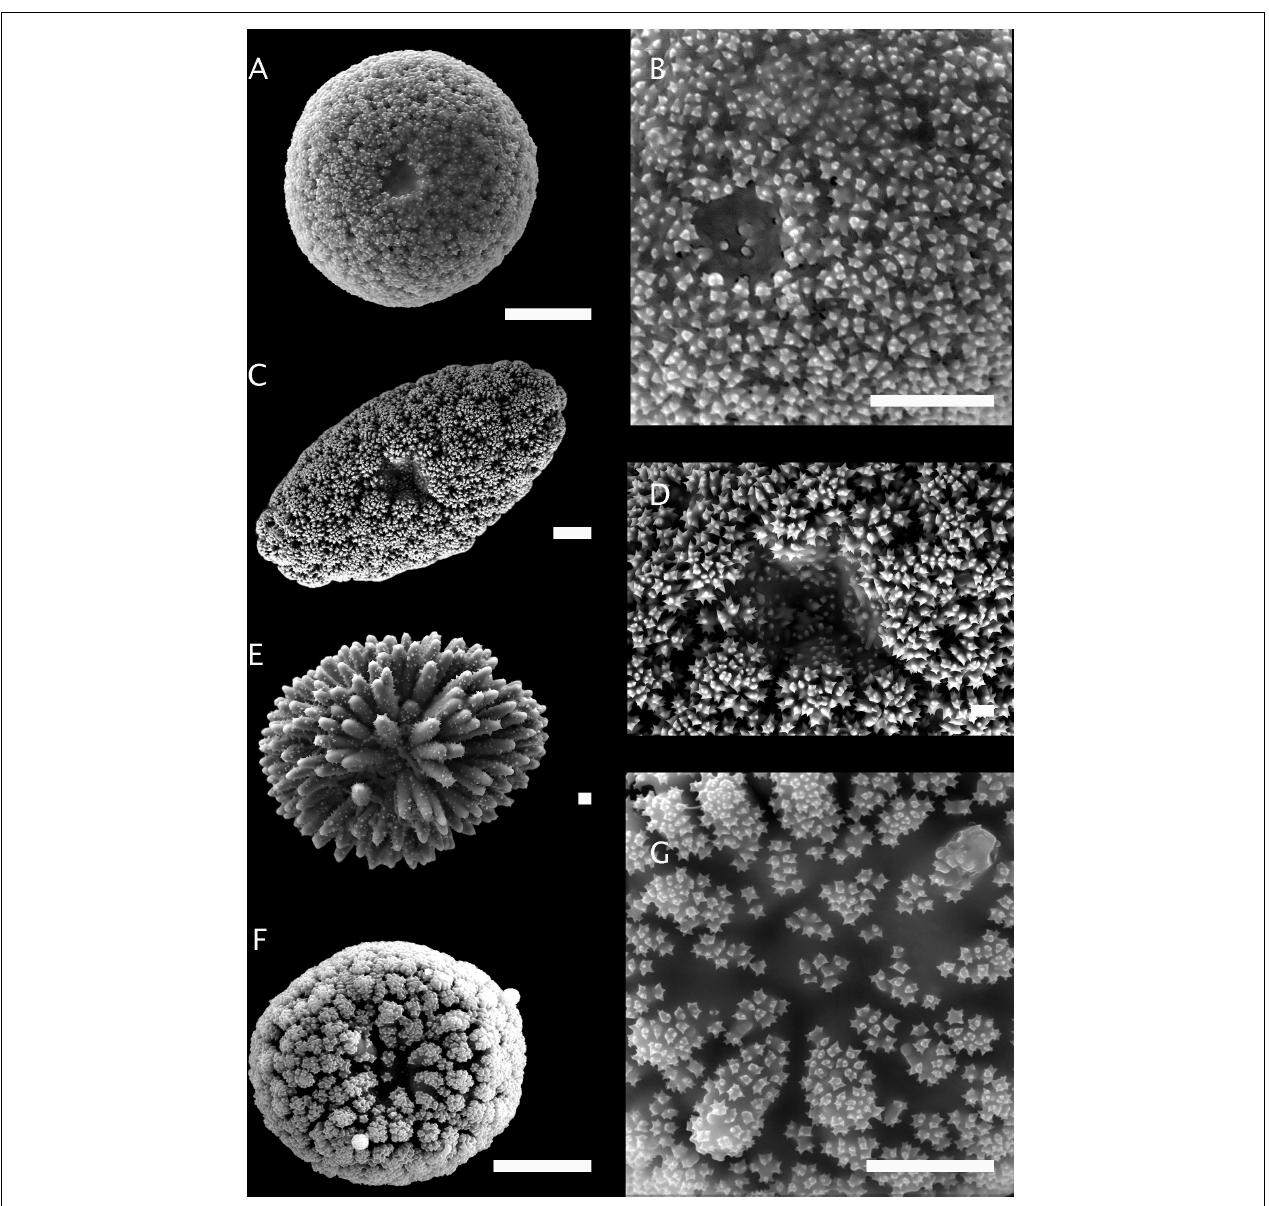
FIGURE 5 | Morphology of sterrasters/aspidasters from Erylus and Caminus . (A,B) Sterraster of Erylus topsenti (South of the Azores, ZMAPOR 21657). Scale A: 38 µ m. Scale B. 20 µ m. (C,D) Aspidaster of Erylus mamillaris (Azores, ZMAPOR 20421). Scale C: 10 µ m. Scale D. 2 µ m. (E) Aspidaster of Erylus discophorus (Portugal, PC81). Scale: 2 µ m. (F,G) Sterraster of Caminella vulcani (Canary Islands, ZMAPOR 20422). Scale F: 30 µ m. Scale G: 15 µ